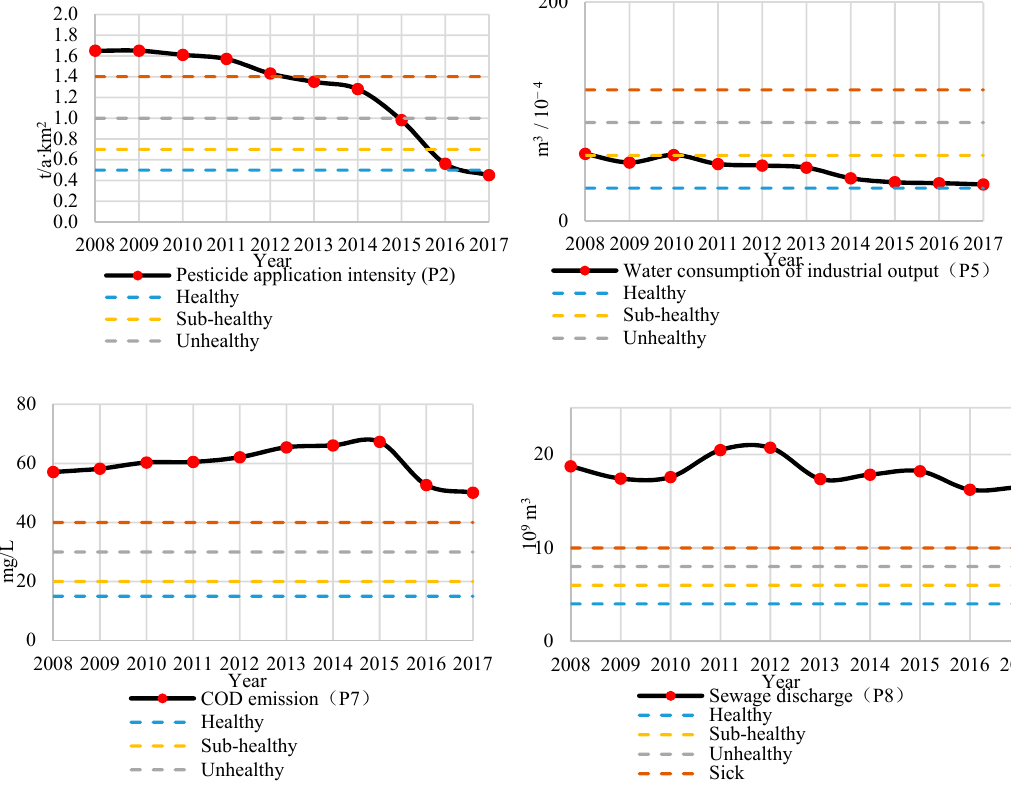
Figure 5. Trends of the main indicators of the pressure subsystem from 2008 to 2017.